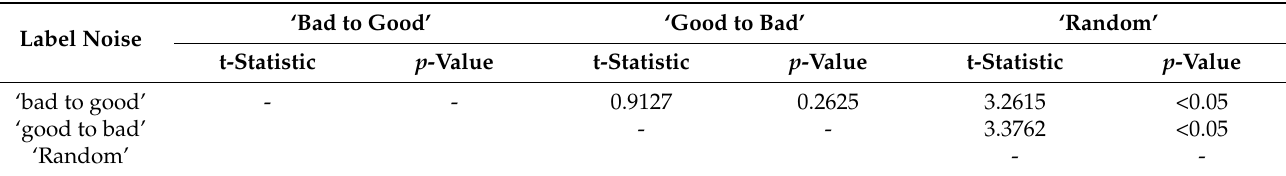
Table 4. Statistical result between different label noise on pairwise t